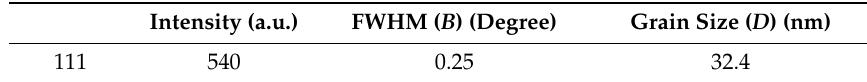
Figure 2. The θ /2 θ XRD patterns of the plasma-enhanced chemical vapor deposition (PECVD) deposited a-Si:H film and the poly-Si film converted from annealing of the a-Si:H film. Table 1. The peak intensity and the full width at half maximum (FWHM: B ) of Si (111) peak, and the grain size ( D ) of the poly-Si films.